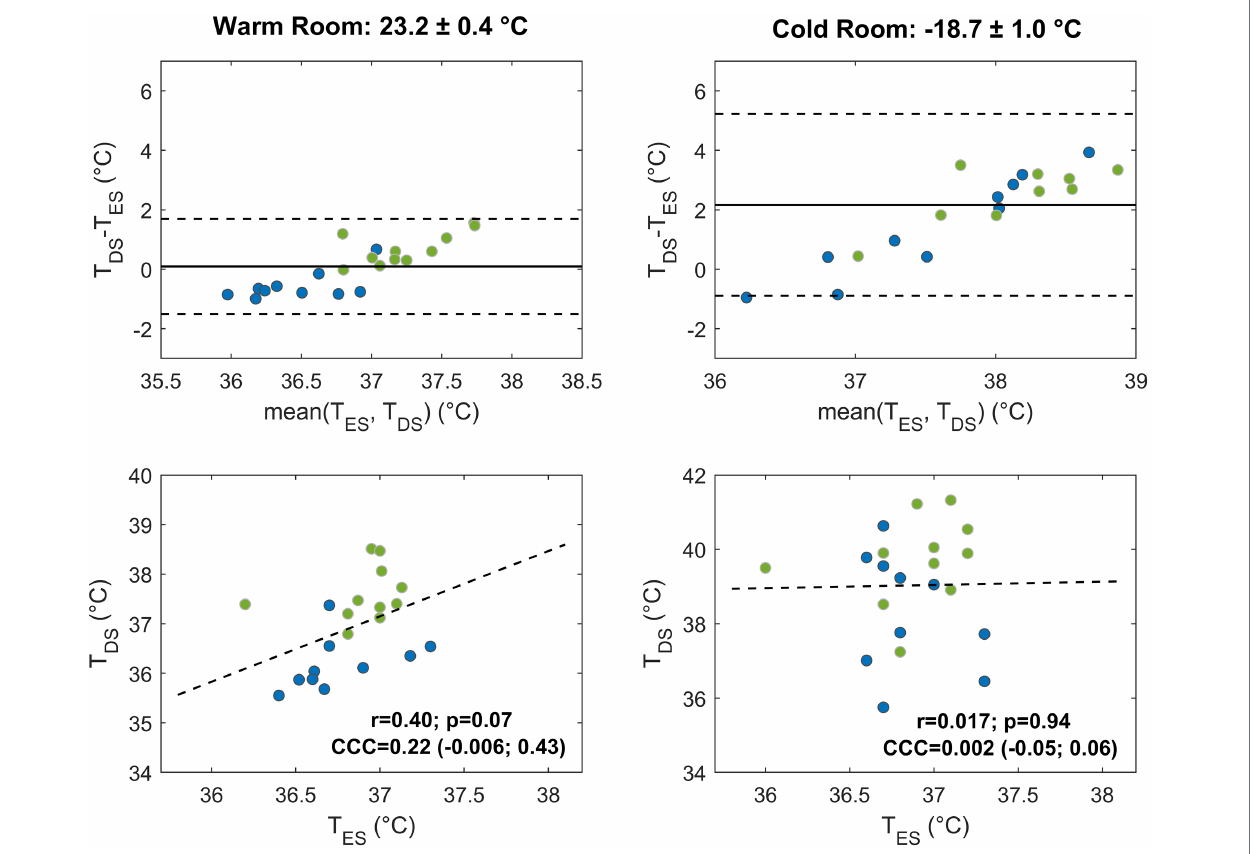
FIGURE 4 | Agreement between temperature values measured by the forehead double sensor (T DS ) and the esophageal sensor (T ES ) after 9 min in the warm (left) and cold room (right) settings. Bland–Altman plots and correlation plots are displayed in the upper and lower panels, respectively, and subjects are color-coded according to the randomization groups (group A, blue; group B, green). In the Bland–Altman plots, the solid line indicates the mean difference and the dashed lines the limits of agreement (mean ± 1.96 standard deviation) for the overall population. In the correlation plots, the linear regression line (dashed line), Pearson’s correlation coefficient (r) with value of p (p), and Lin’s concordance correlation coefficient (CCC) and confidence interval, are indicated for the overall